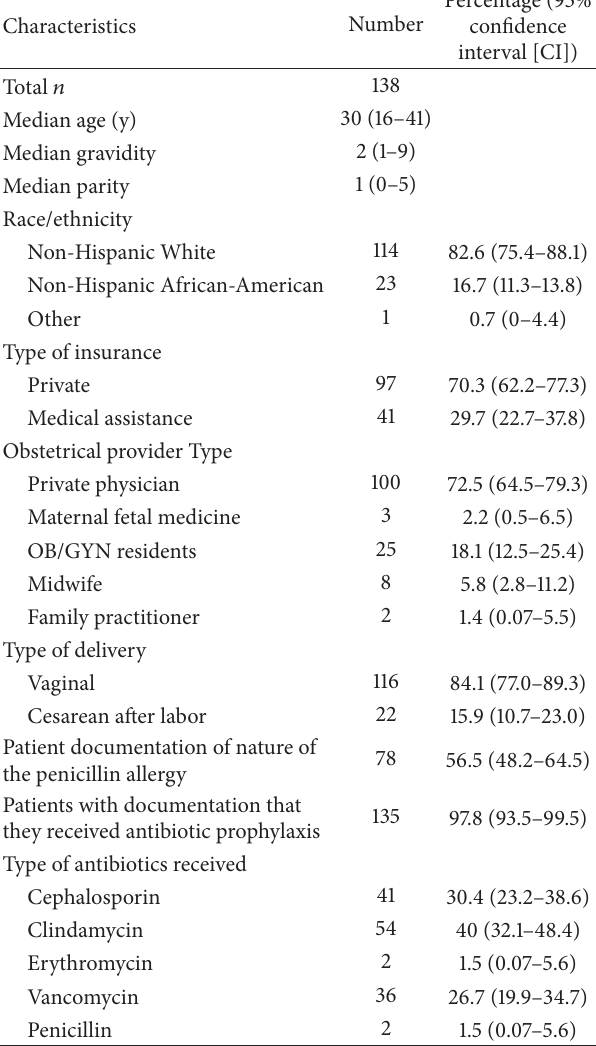
Table 1: Characteristics of the GBS+, penicillin-allergic patients who delivered at Magee-Womens hospital in 2010 (postexclusion